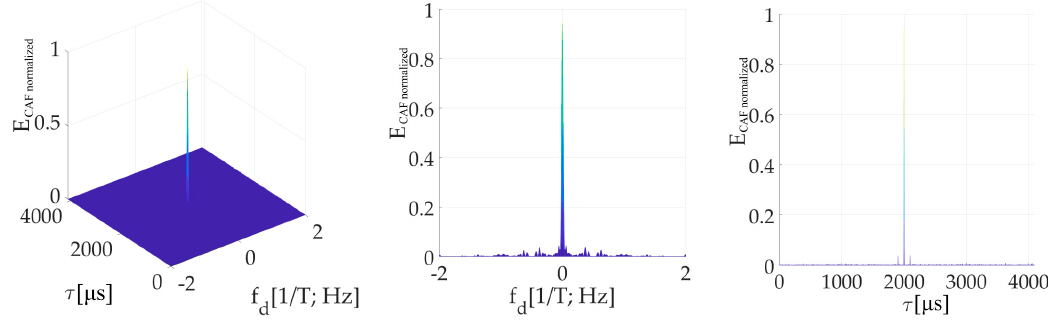
Figure 24. CAF of mPCA mSBZP for SC algorithm for τ = (1 / 2) T . CAF ( left ), Dopler shift domain ( middle ), Code phase domain ( right